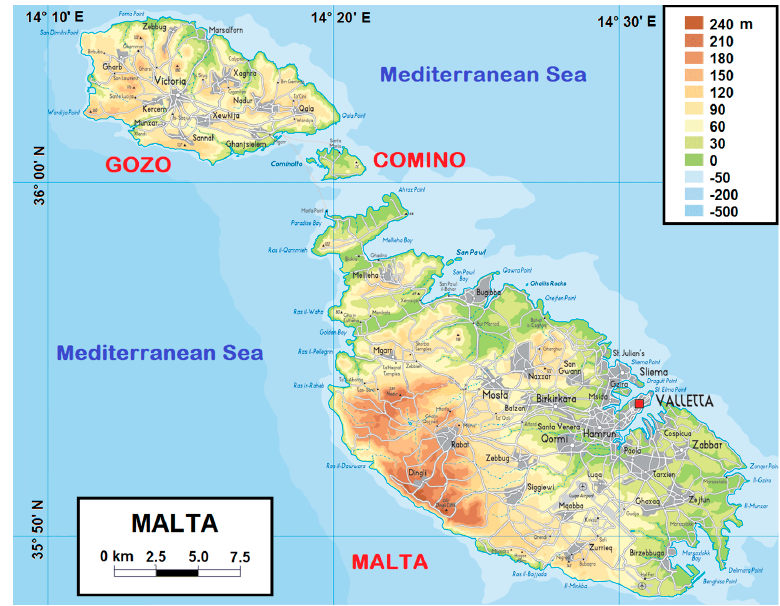
Figure 2. View of the Maltese Archipelago.